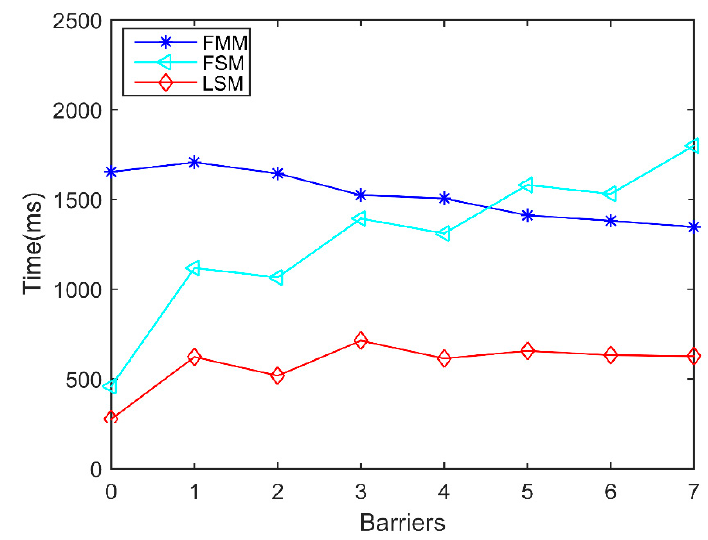
Figure 19. Computation times of the FMM, FSM, and LSM for the barriers experiment.